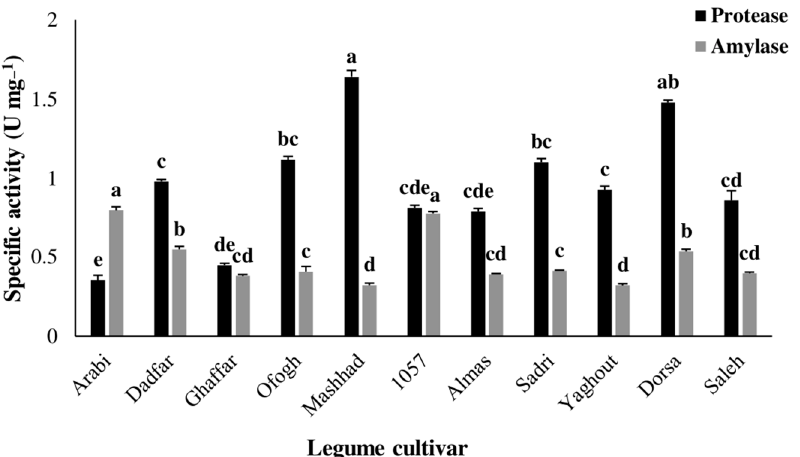
Figure 3. General proteolytic and amylolytic activity of midgut extracts from Spodoptera littoralis larvae reared on various legume cultivars. Each column represents the mean of four independent estimations ± standard error (SE). Different letters indicate statistically significant differences (Tukey, p < 0.01).